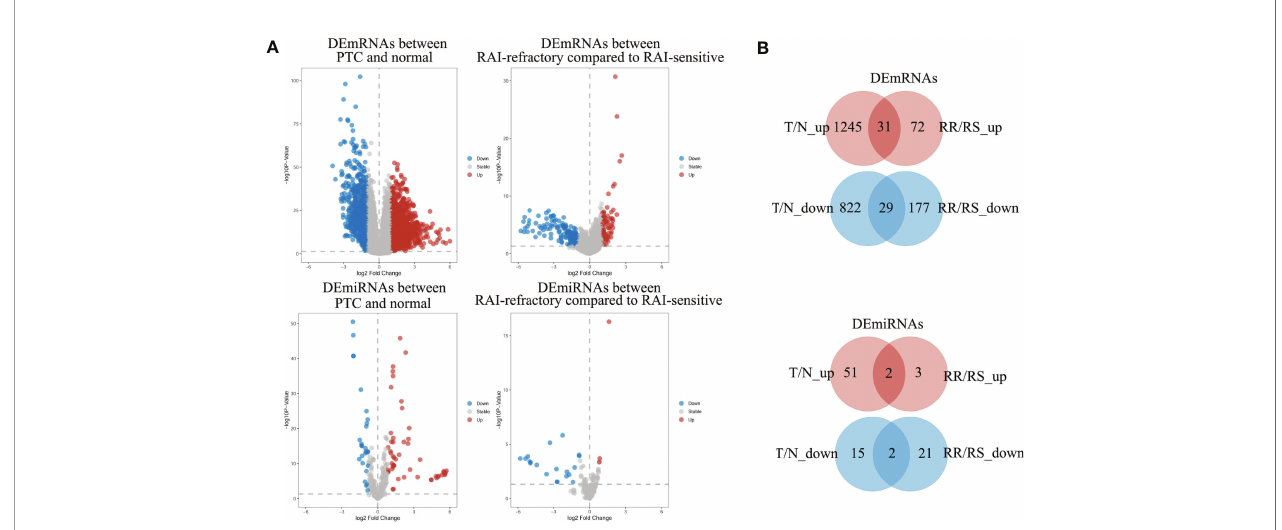
FIGURE 2 | The volcano plots and Venn diagrams showed the DEmRNAs and DEmiRNAs in two comparisons. (A) Volcano plots of DEmRNA and DEmiRNA expressions in the PTC group compared to normal groups (T/N) and in the RAI-refractory group compared to the RAI-sensitive group (RR/RS). Red represents upregulated RNAs, and blue indicates downregulated RNAs. (B) Venn diagrams showed the overlap of signi fi cantly up- and downregulated DEmRNAs and DEmiRNAs in the two comparisons above.